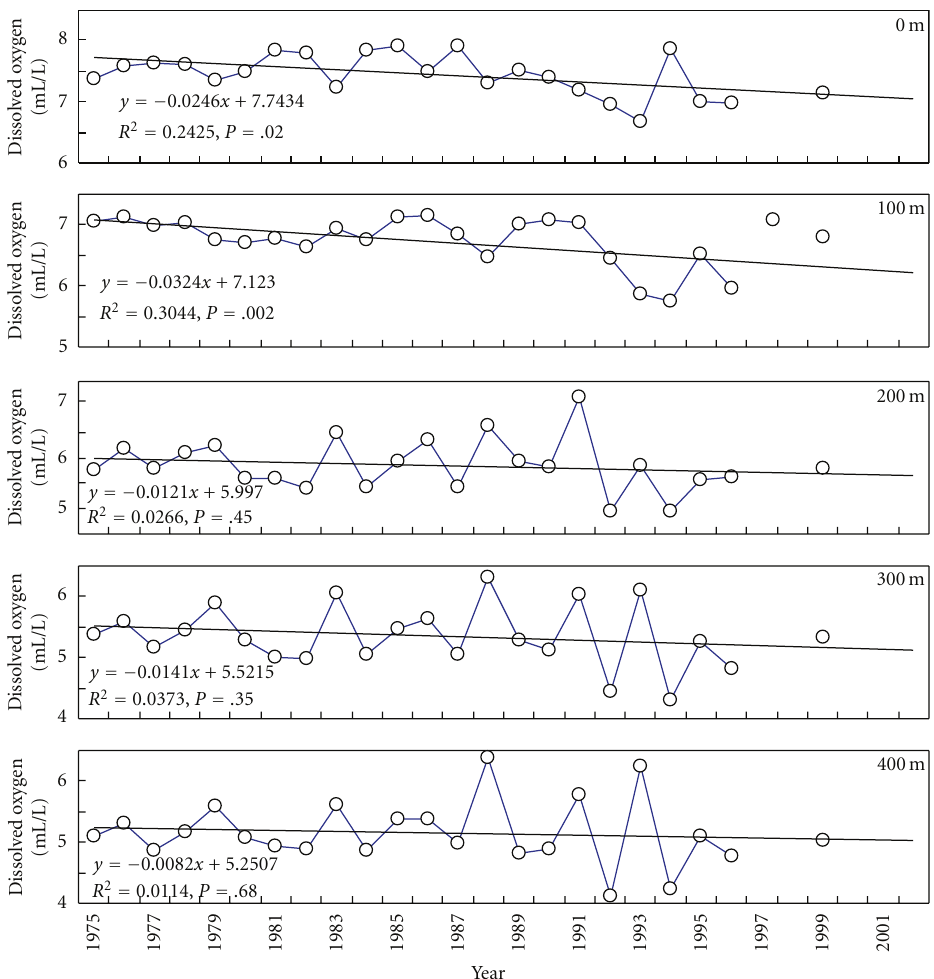
Figure 7: Long-term time series of the mean concentrations of the dissolved oxygen at the surface, 100m, 200 m, 300 m, and 400m during austral summer (January–March) between 1975 and 2002. Solid lines represent linear